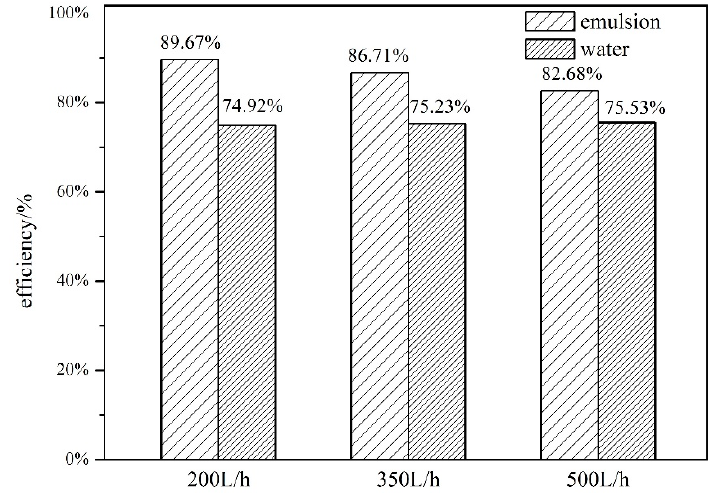
Figure 17. Thermal efficiency under different flow rates.